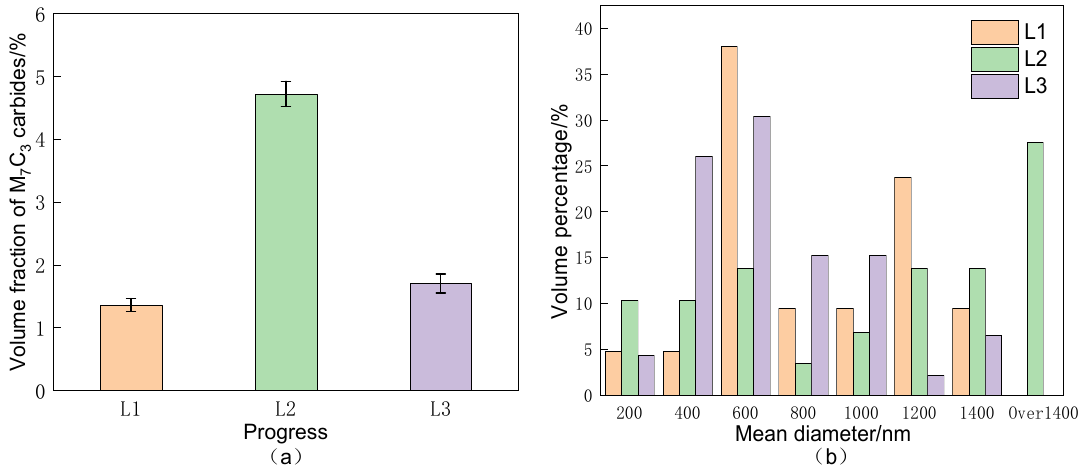
Figure 6. EMPA at 0.1 mm on the surface of process L2.